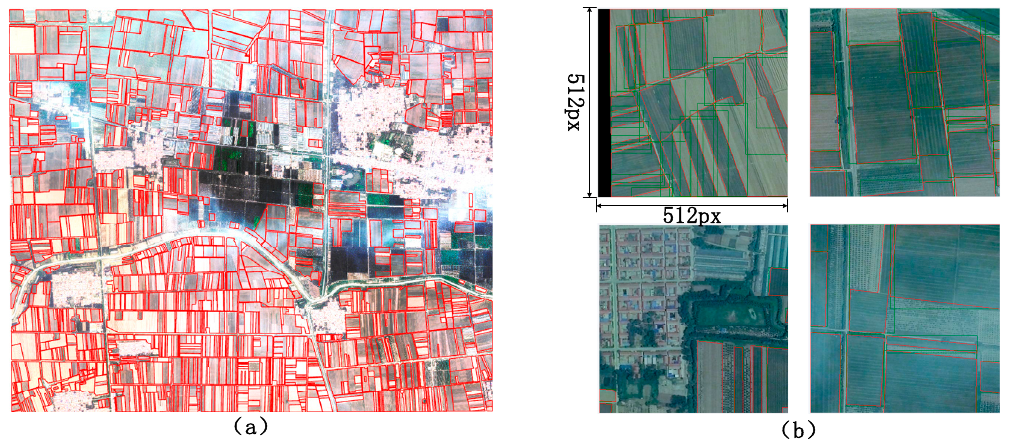
Figure 1. ( a ) One of the original images and its corresponding labels provided with the original dataset. ( b ) The visualization result after conversion of the dataset to COCO format with its size fixed at 512 × 512.